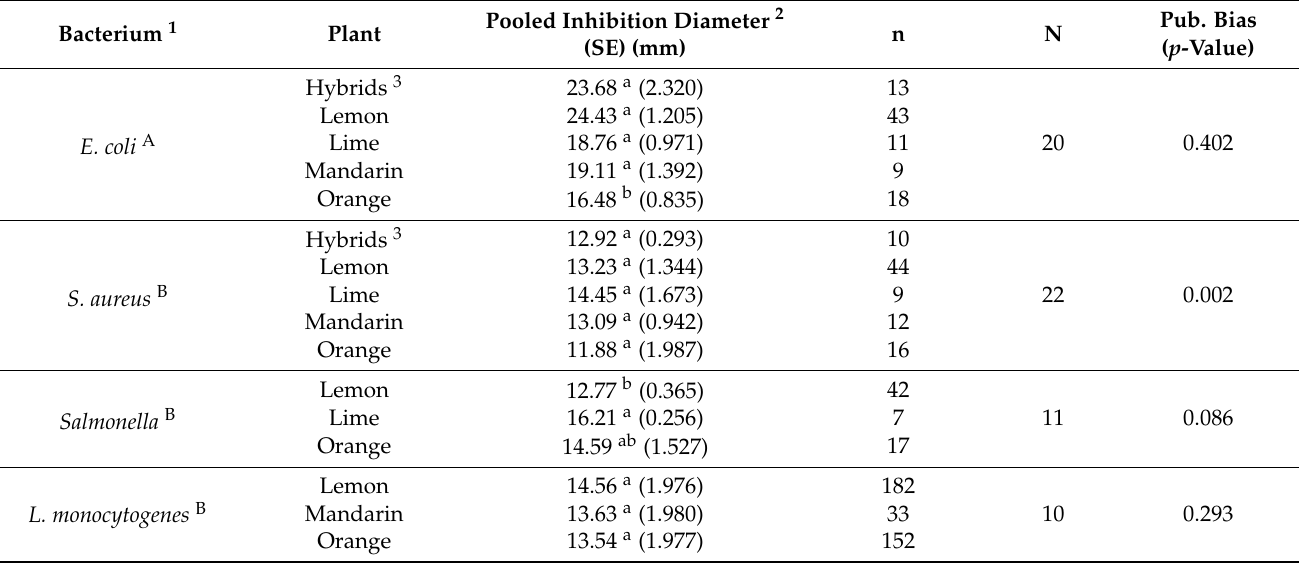
Table 1. Pooled inhibition diameters (mean and standard error, SE, in mm) of Citrus species EOs against specific bacteria using separate meta-analysis models. Number of observations (n), number of primary studies (N), and p -value of the publication bias test are presented for each